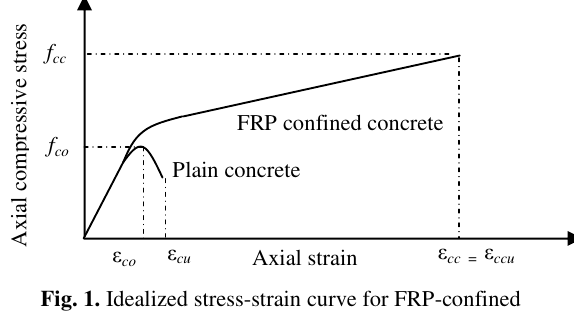
Fig. 1. Idealized stress-strain curve for FRP-confined concrete